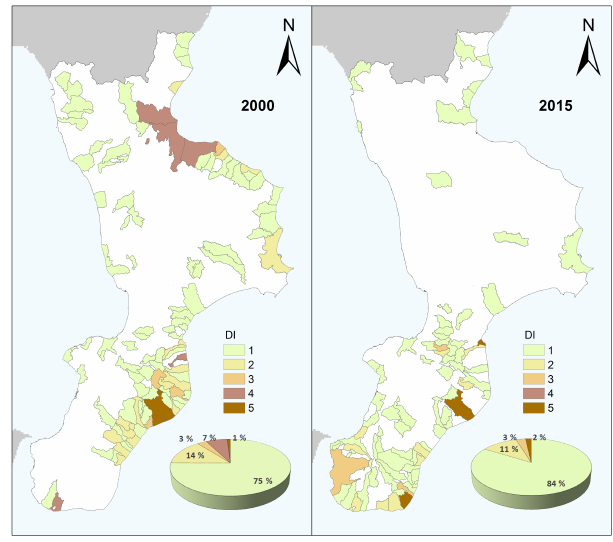
Figure 7. Classification of municipalities of Calabria according to the classes of Damage index (DI) listed in the legend. 1: low dam- age; 2: low-medium damage; 3: medium damage; 4: high damage; 5: very high